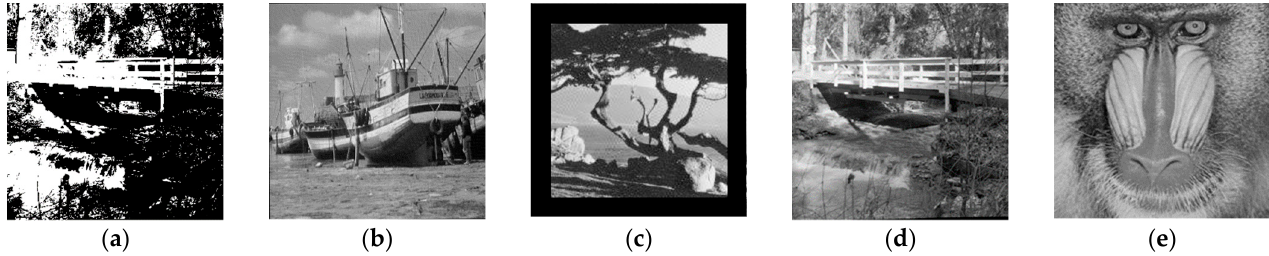
Figure 11. Watermarked images with geometrical attacks ( a ) bit plane removal, ( b ) rotation 0.25 degree, ( c ) surrounding crop 15%, ( d ) resizing 512 to 256, and ( e ) resizing 512 to 200.